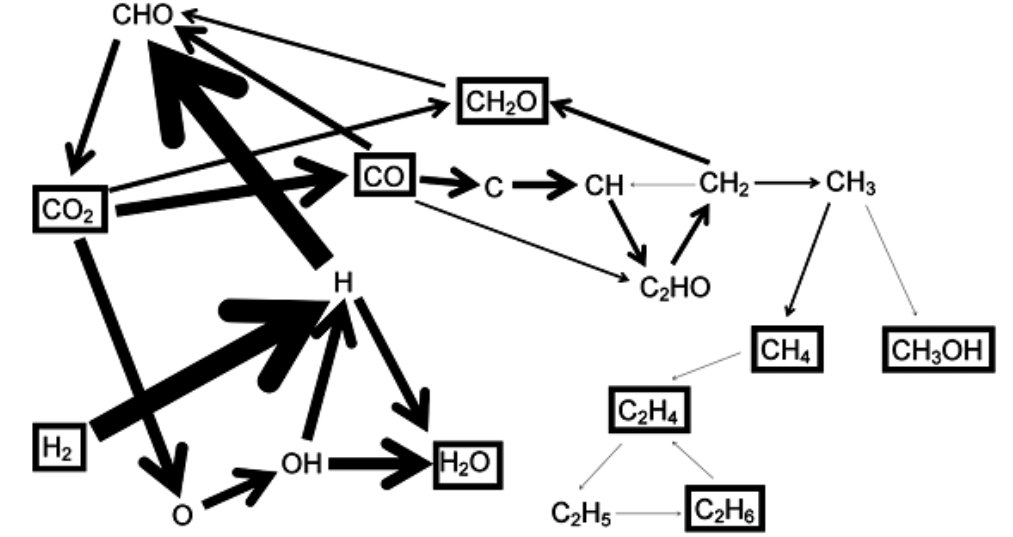
Scheme 5. Dominant reaction pathways for the plasma-based conversion (without catalysts) of CO 2 and H 2 into various products, in a 50/50 CO 2 /H 2 gas mixture. The thickness of the arrow lines is proportional to the rates of the net reactions. The stable molecules are indicated with black rectangles, reprinted with permission from [126]. Copyright American Chemical Society, 2016.